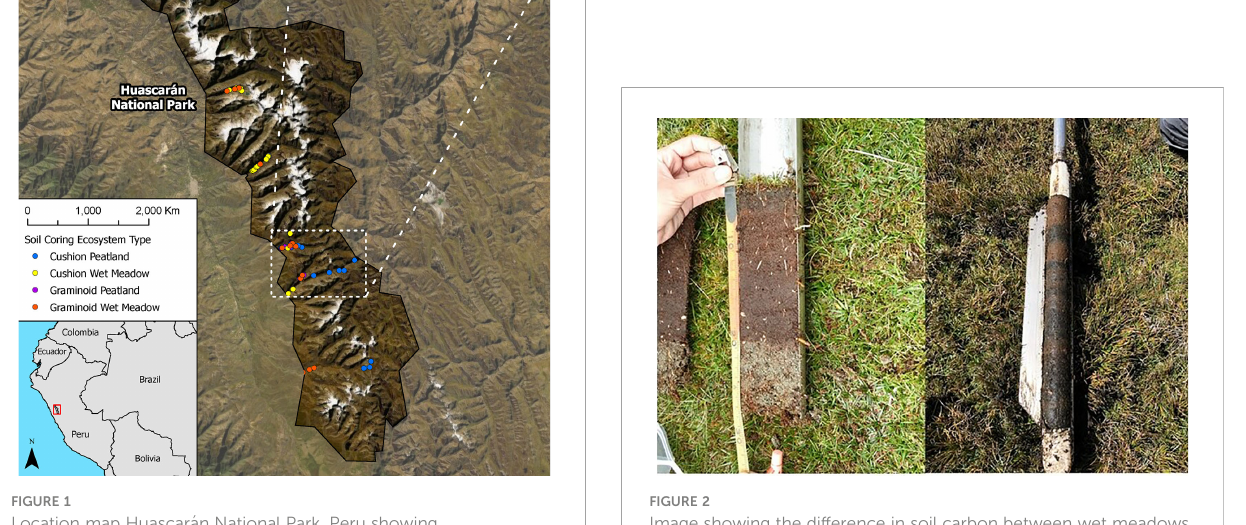
(left) and peatlands (right).